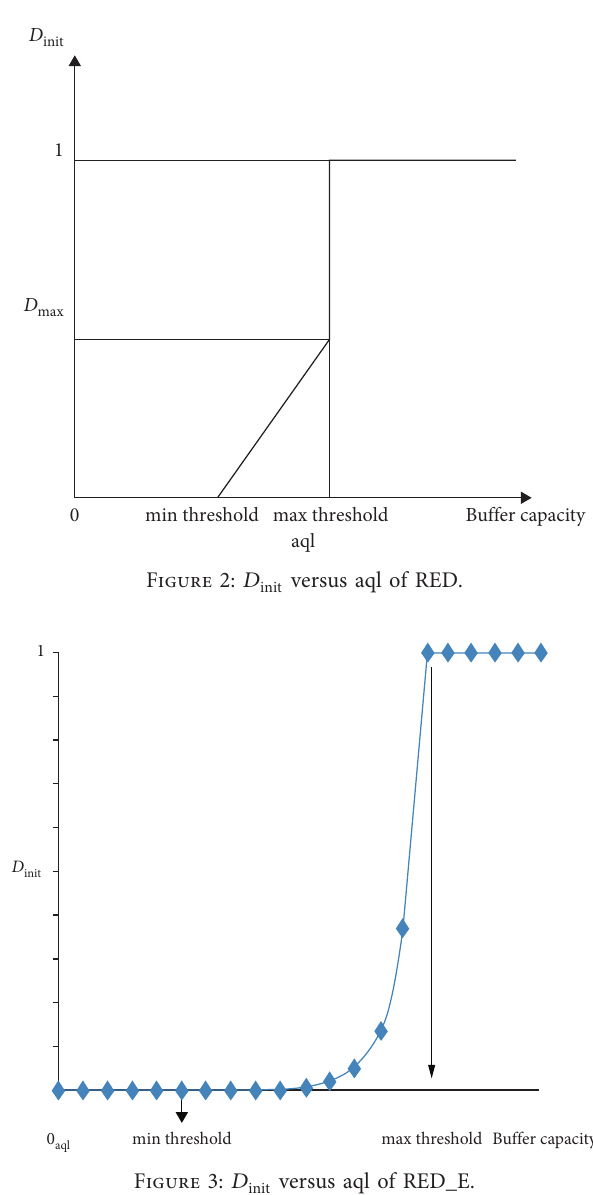
versus aql of RED_E. init